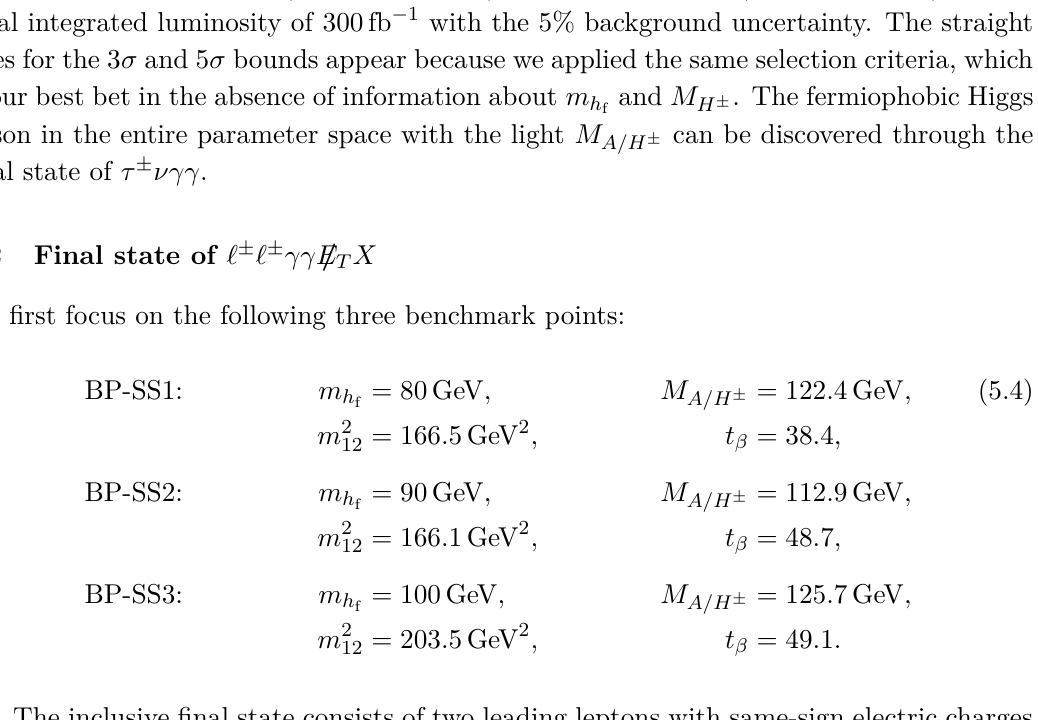
Figure 12 . The detector-level cross sections of σ ( pp → τ ± νγγ ) about M the advanced cuts, described in the text, at the 14 TeV LHC. The color code denotes t β . The results of m h = 80 , 90 , 100 GeV are respectively in the left, middle, and right panel. f We present the 3 σ bound (blue-dashed line) and the 5 σ bound (red-dashed line) for